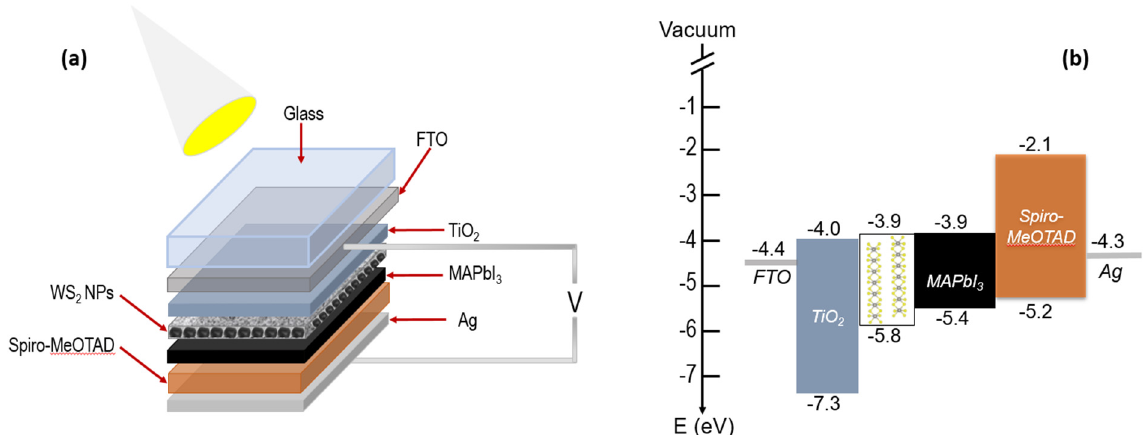
Figure 5. ( a ) configuration of WS 2 NPs/MAPbI 3 heterostructure-based PSCs, and ( b ) schematic energy level diagram.